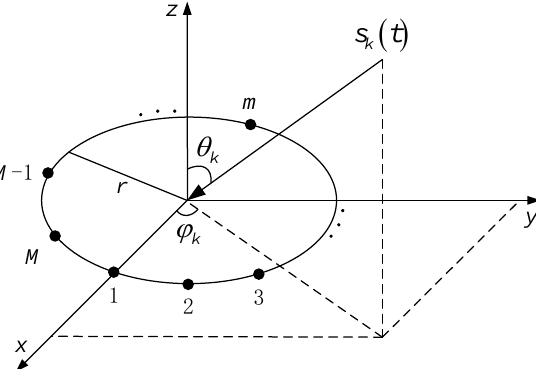
Figure 1. Geometry configuration of the